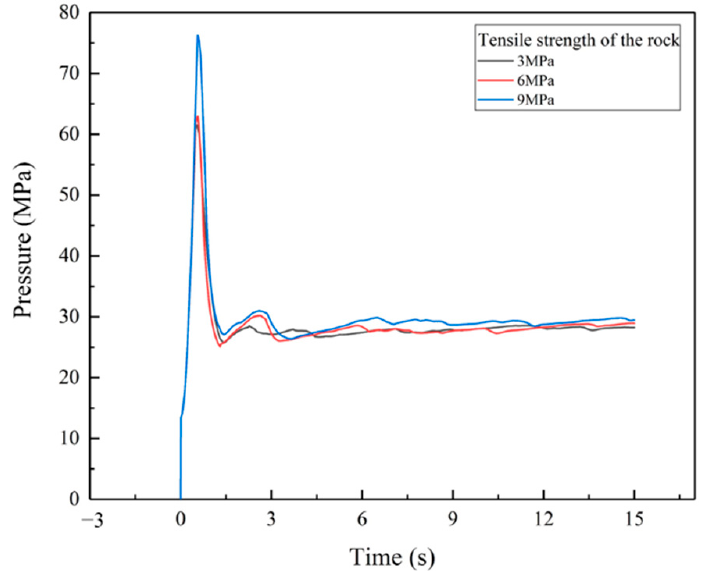
Figure 21. The bottom hole pressure under different tensile strengths of rock.